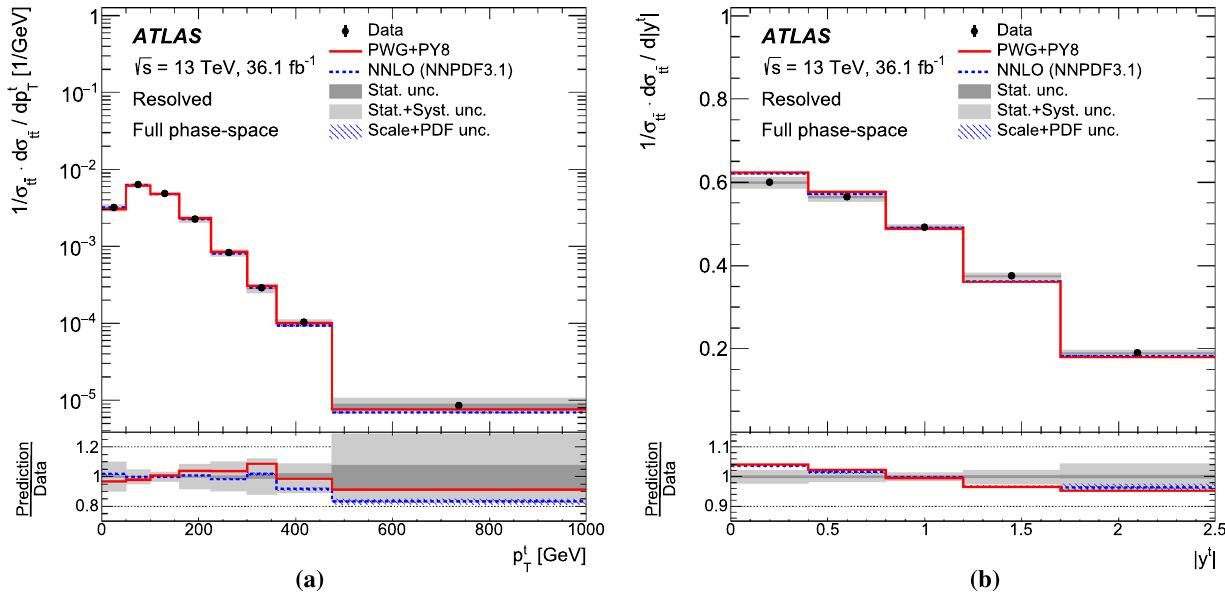
Fig. 55 Parton-level normalised differential cross-sections as a func- tion of a the p T and b normalised rapidity of the top in the resolved topology, compared with the NNLO predictions obtained using the NNPDF3.1 NNLO PDF set and the predictions obtained with the Powheg + Pythia8 MCgenerator.Thehatchedbandrepresentsthetotal